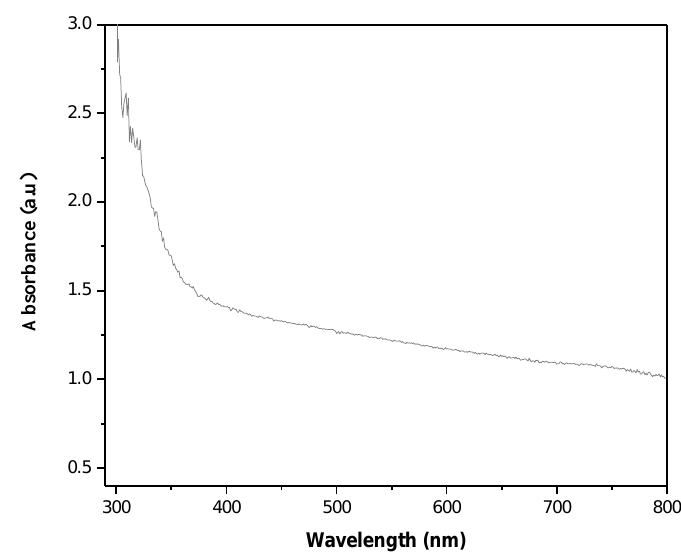
Figure 6. UV–vis analysis of Fe/Cu bimetallic nanoparticles. Figure 6. UV – vis analysis of Fe/Cu bimetallic nanoparticles. Figure 7 represents the TEM image of Fe/Cu bimetallic nanoparticles.